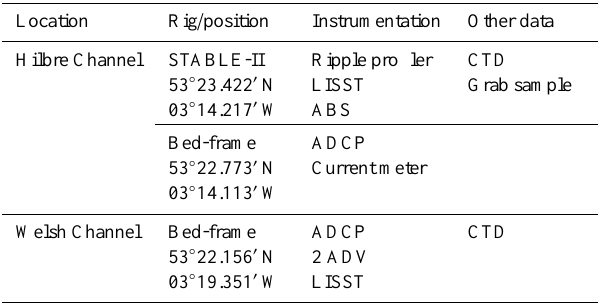
Table 3. Summary of the March 2004 data.